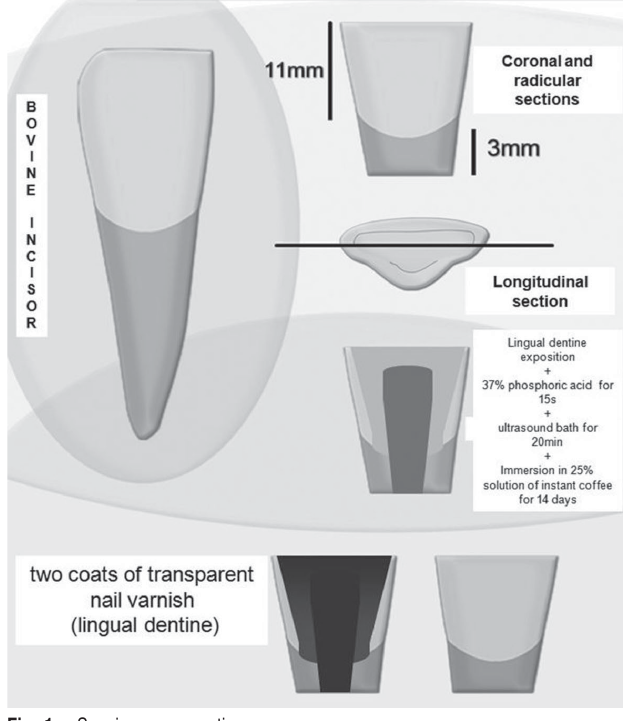
Fig. 1 – Specimen preparation.